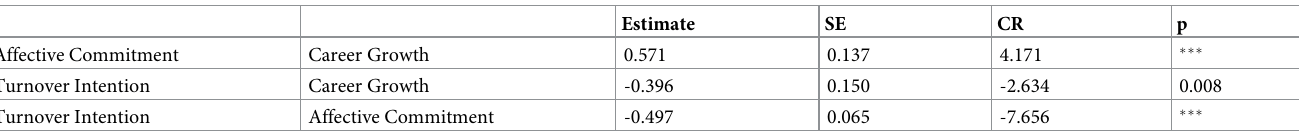
Table 13. Regression